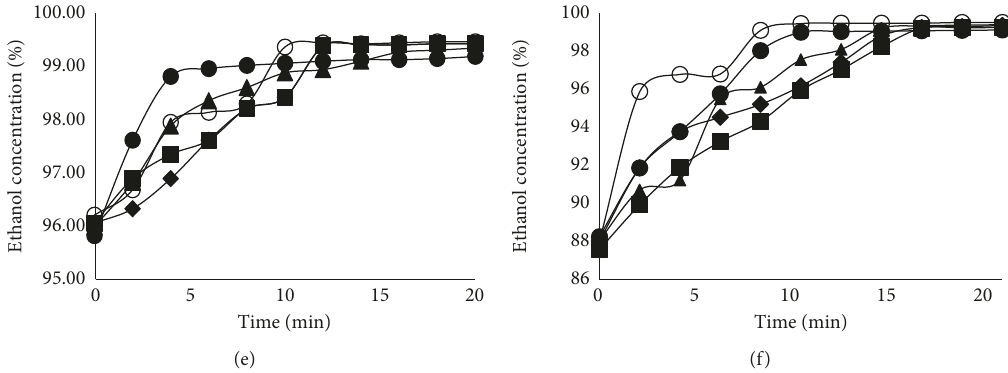
Figure 5: Ethanol concentration vs. time for various adsorbents at the same temperature and initial water concentration. (a) Ethanol concentration 96% and temperature 22 ° C; (b) Ethanol concentration 88% and temperature 22 ° C. (c) Ethanol concentration 96% and temperature 30 ° C. (d) Ethanol concentration 88% and temperature 30 ° C. (e) Ethanol concentration 96% and temperature 40 ° C. (f) Ethanol concentration 88% and temperature 40 ° C. , PVA/Zeo/AC 1 :1:1; ■ , PVA/Zeo/AC 1:1 :0.75; , PVA/Zeo/AC 1:1 :0.5; , PVA/Zeo/AC 1: 1: 0.25; , PVA/Zeo/AC 1:1